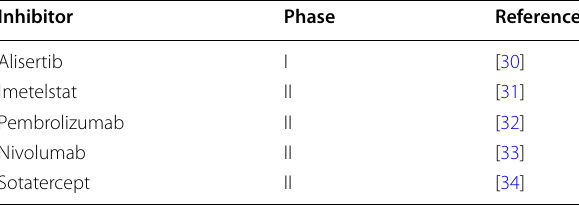
Table 2 Clinical trials of non-JAK targeted drugs for myelofibrosis Inhibitor